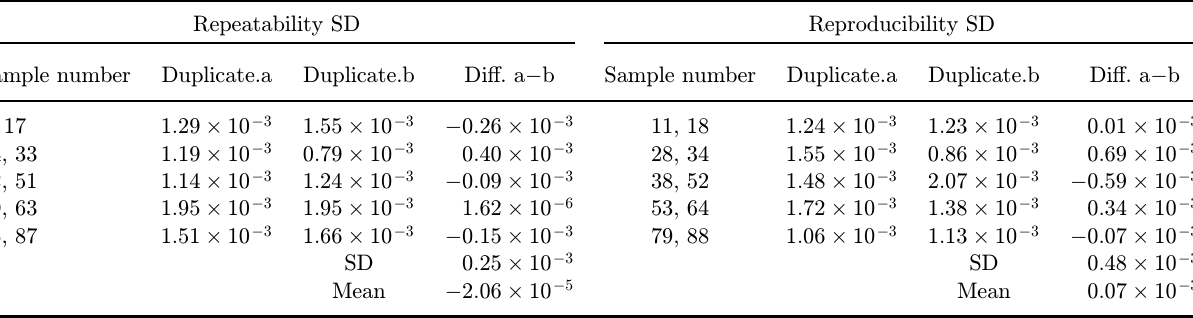
Table 3. Repeatability and reproducibility of reference test for gamma oryzanol of GBR. (mg/100 g dry